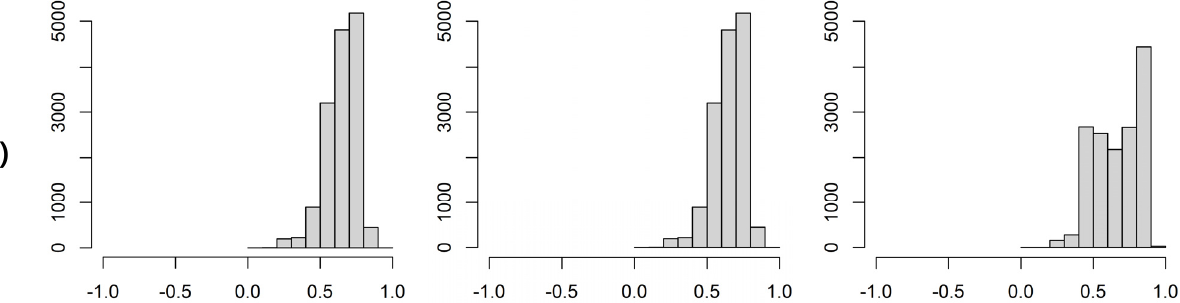
Figure 3. RGB and NDVI image of Geomunoreum forest from 2017 to 2019. ( a ) RGB image; ( b ) NDVI image; ( c ) histogram of NDVI frequency distribution.